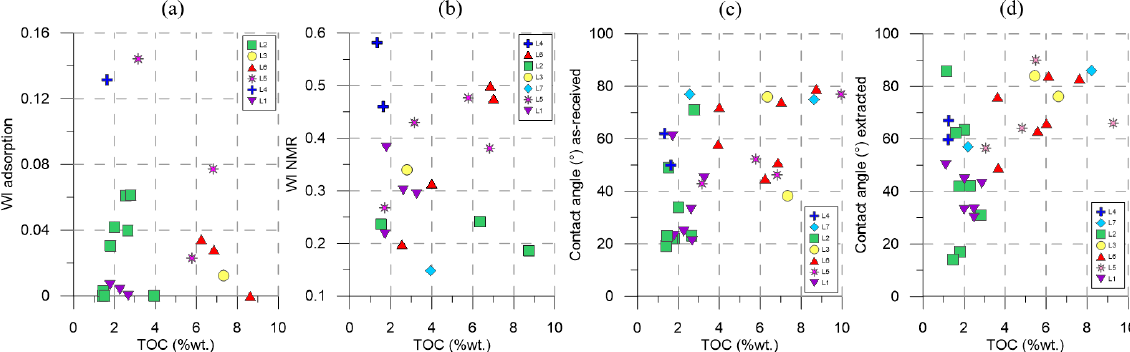
Figure 4. Crossplots showing correlations of TOC vs. (a) WI adsorption, (b) WI NMR, (c) contact angle in as-received state and (d) contact angle for extracted rock with indication of the lithotype.